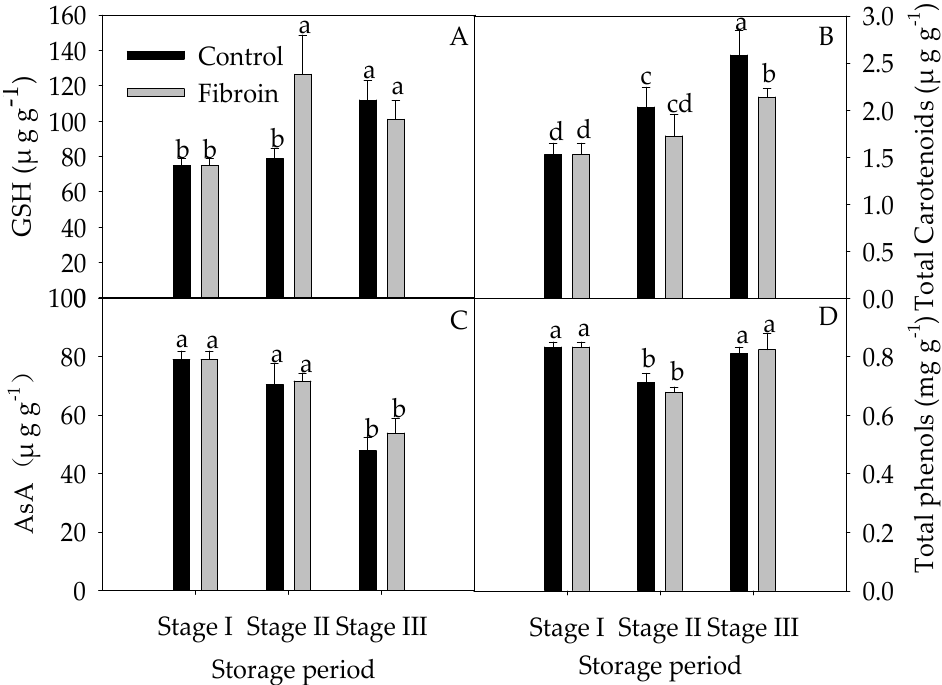
Figure 2. Effect of fibroin treatment on contents of glutathione ( A ), total carotenoids ( B ), ascorbic acid ( C ), and total phenols ( D ) in peels of harvested banana fruit during cold storage. The data are presented as means ± standard errors ( n = 3). The means with different letters are significantly different ( p < 0.05). GSH, glutathione; AsA, Ascorbic Acid.